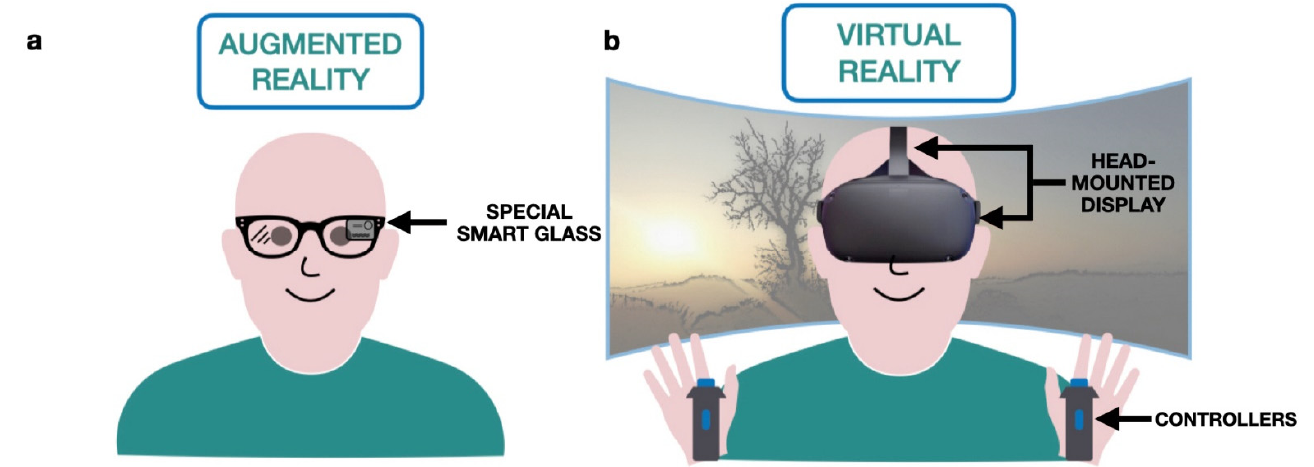
Figure 1. Illustrations of two examples of Augmented Reality (AR) and Virtual Reality (VR). ( a ) AR: the user sees the digital information superimposed with the reality by special smart glass (black arrow). ( b ) VR: the user is completely immersed in a virtual environment by head-mounted display (black arrows) and can interact with it using specific controllers (black arrow).